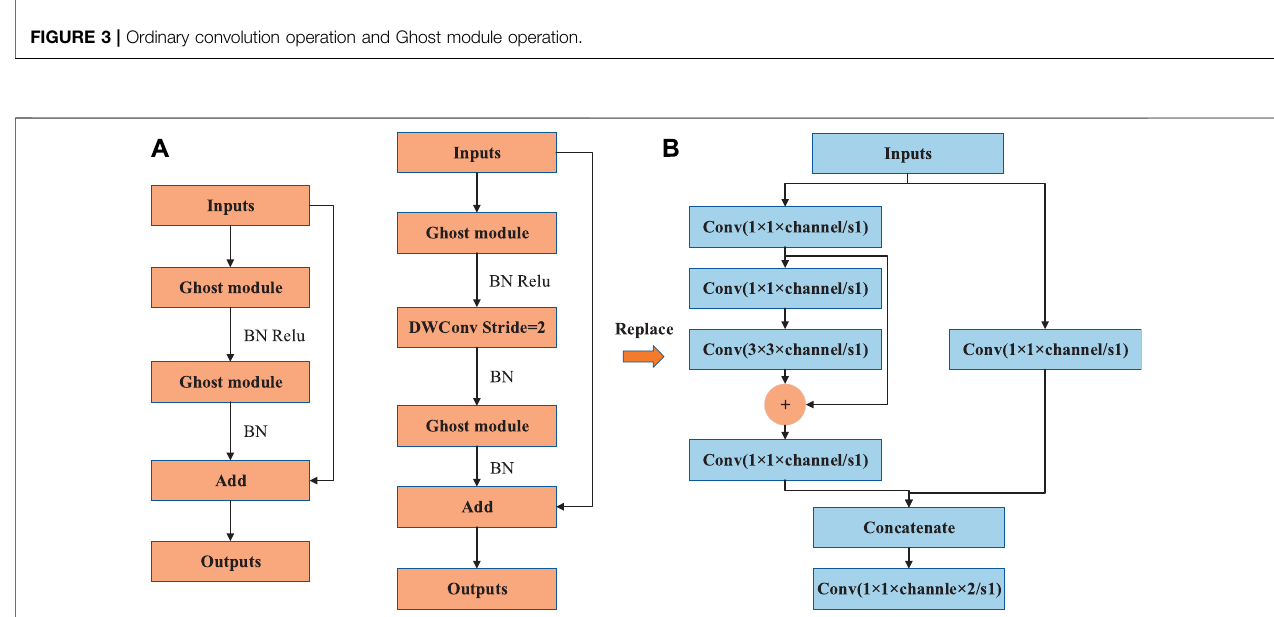
FIGURE 4 | Ghost bottleneck module and Resblock_body structure: (A) Ghost bottleneck structure with stride (cid:2) 1,2 (B) Resblock_body.